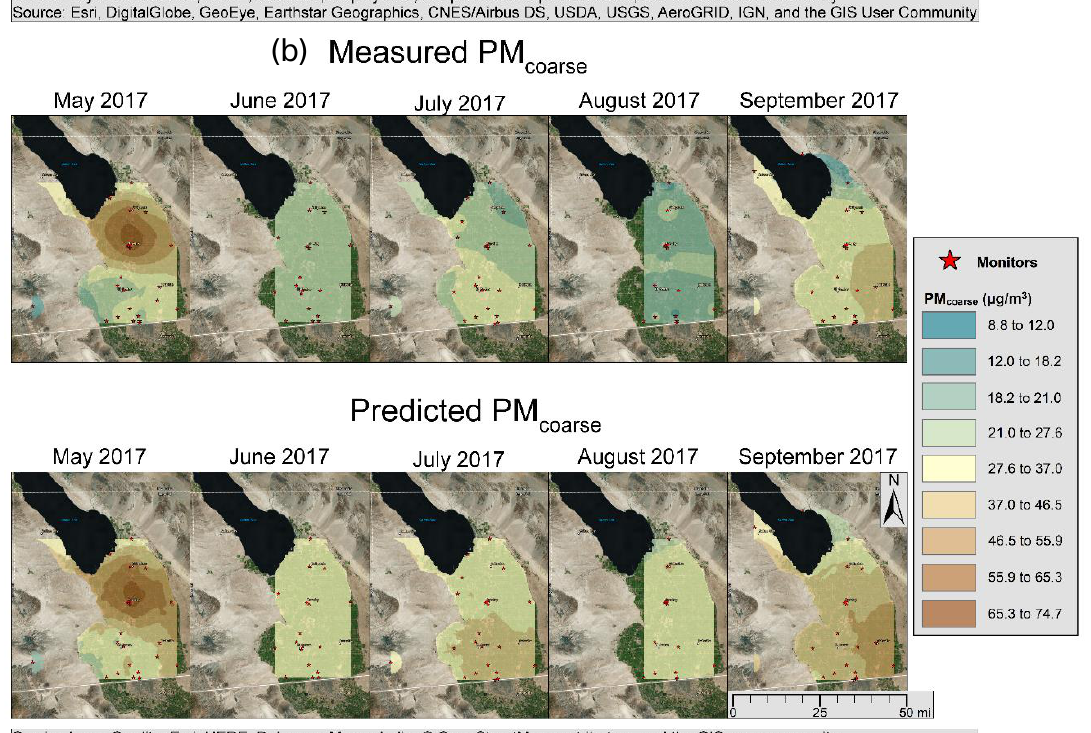
Figure 5. ( a ) Monthly measured and predicted PM coarse (December–April 2017); ( b ) monthly measured and predicted PM coarse (May–September